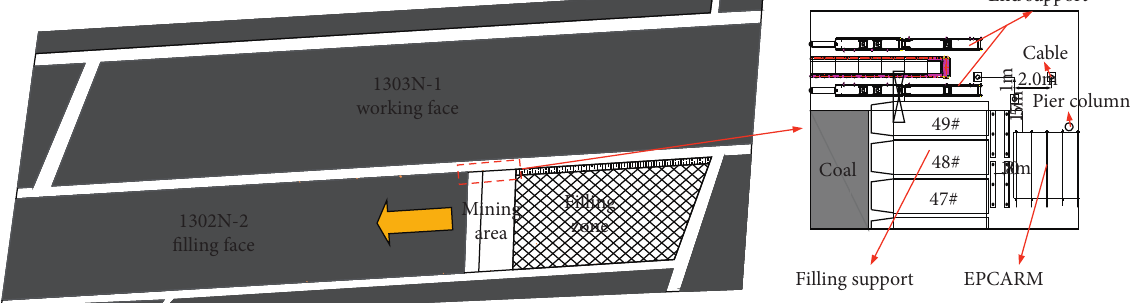
Figure 1: The filling gob-side entry layout.